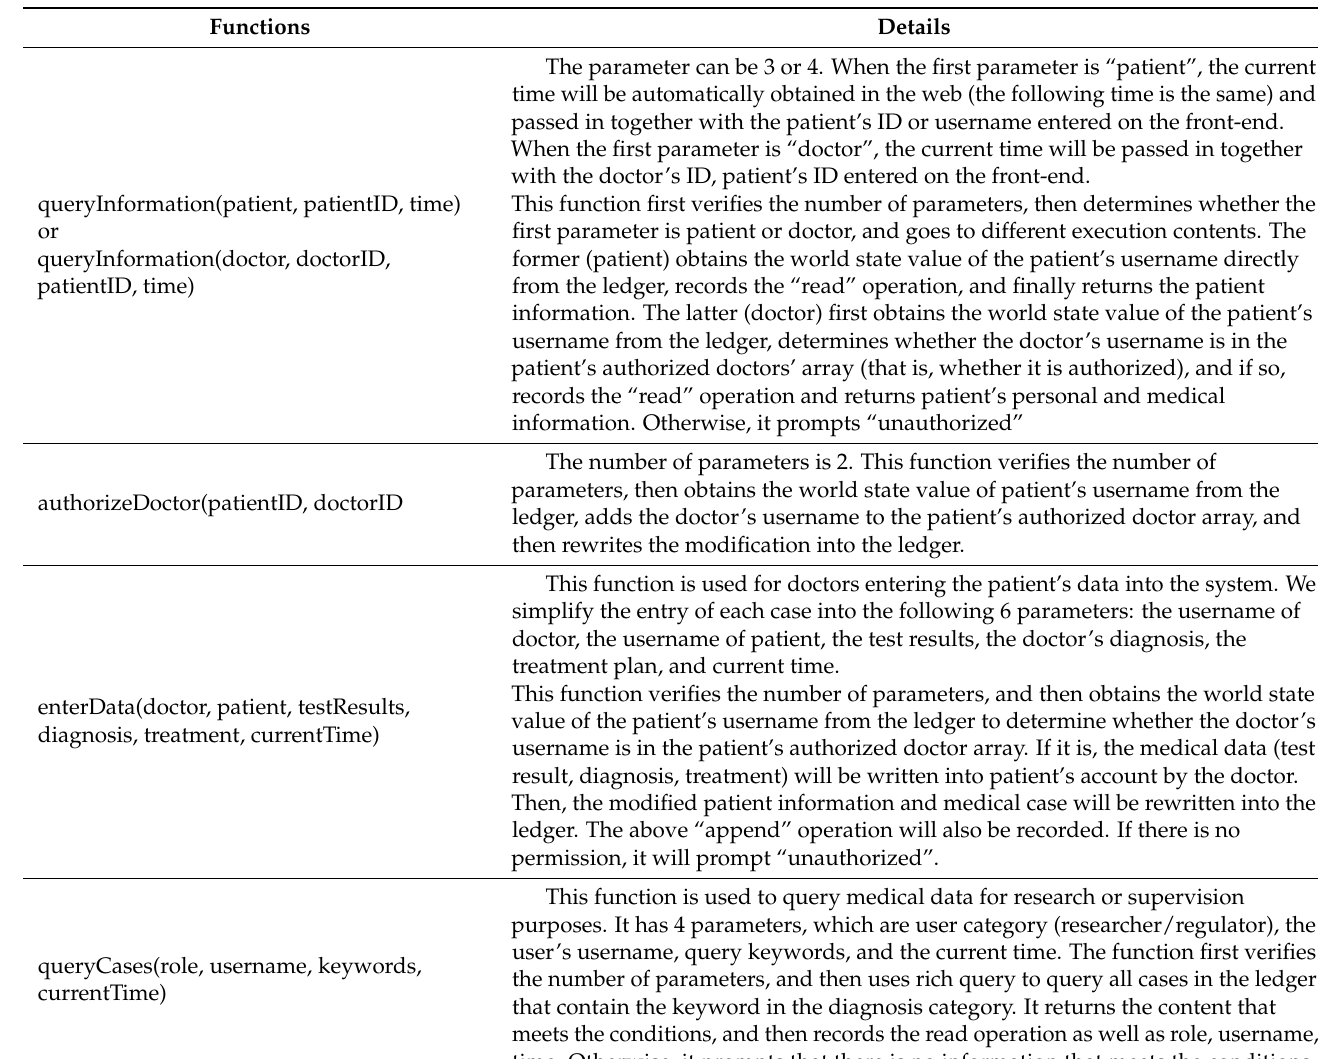
Table 3. Functions in the smart